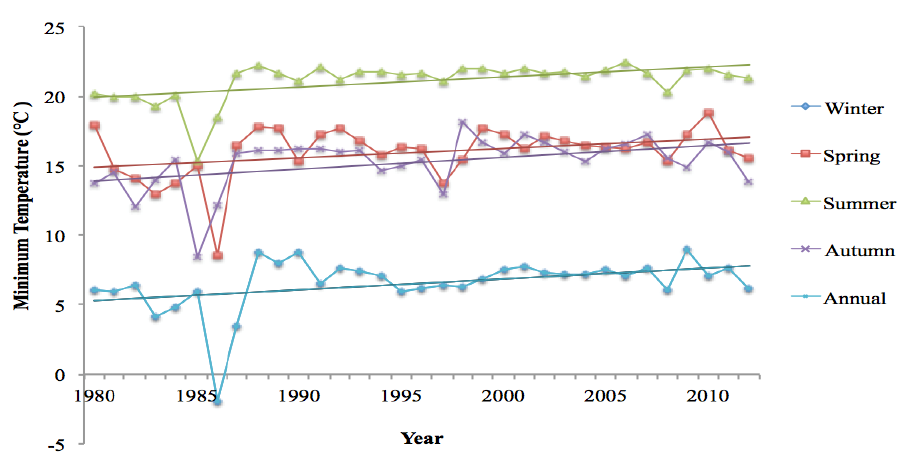
Figure 5. Seasonal and annual minimum temperature trends at the Khudi station from 1980 to 2012.